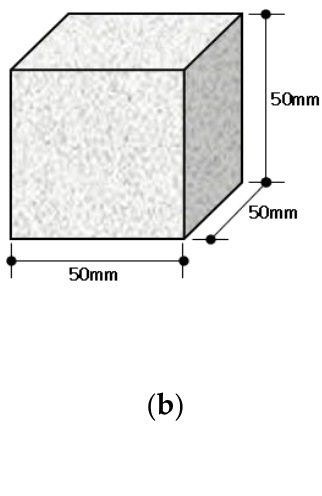
Figure 2. Slump-flow test: ( a ) Test setup; ( b ) Cube specimen.